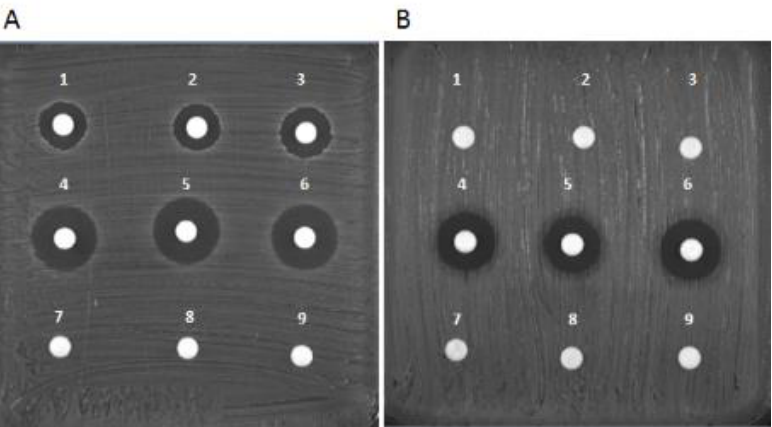
Figure 6. Disk diffusion test results for S. aureus ATCC 25923 ( A ) and P. aeruginosa ATCC27853 ( B ). Samples 1,2: MgHA/Coll 70/30 + VNC; sample 3: VNC 10 µg; samples 4,5: MgHA/Coll 70/30 + GNC; sample 6: GNC 10 µg; samples 7,8: MgHA/Coll 70/30; sample 9: sterile paper